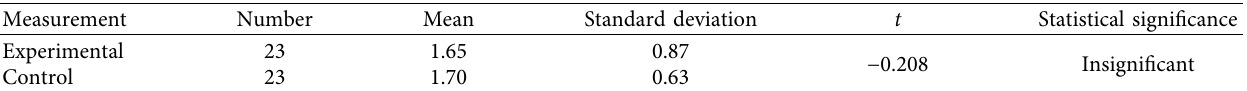
Table 6: . The results of the t -test and the significance of the differences for the dimensional measurement of the two groups, the ex- perimental group and the control group, in the test of reading comprehension skills at the level of deductive